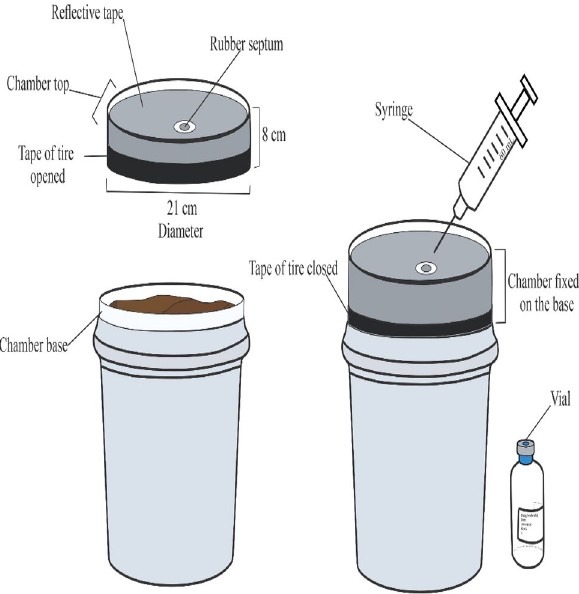
Figure 6. Static chamber details and instruments for GHG collection in the dung beetle